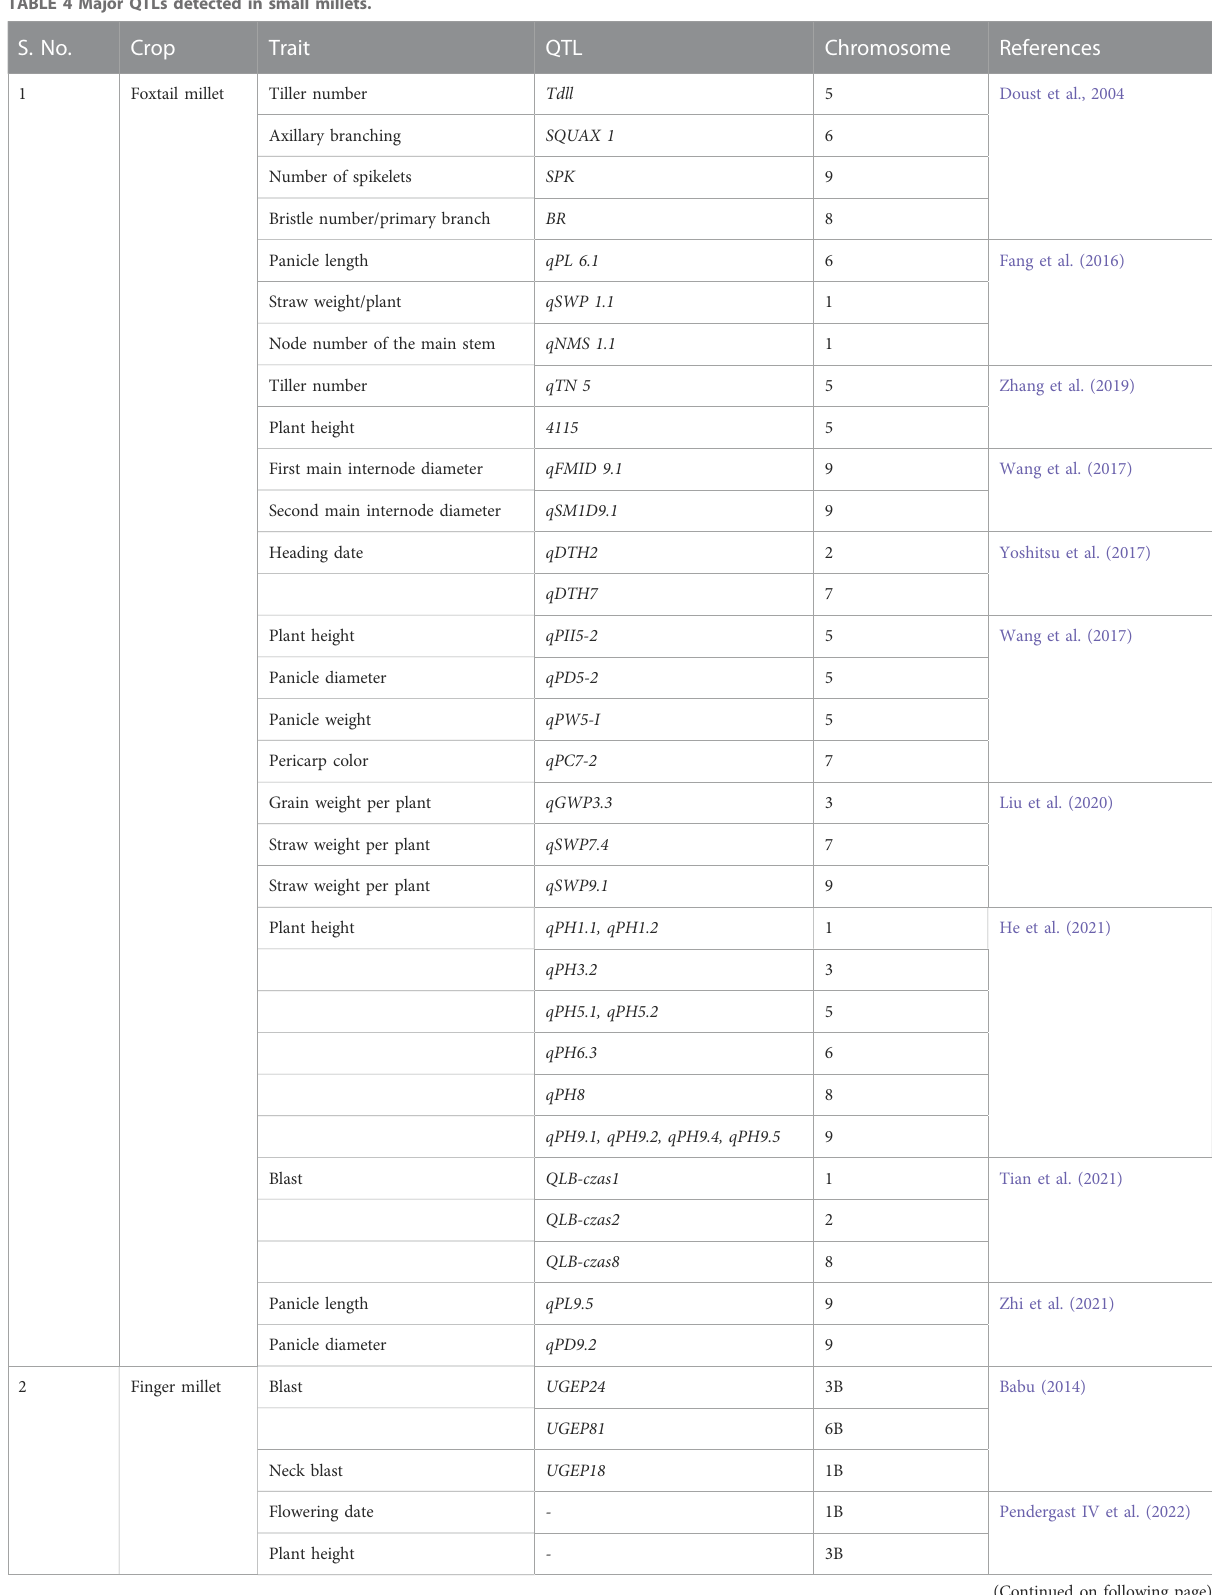
TABLE 4 Major QTLs detected in small